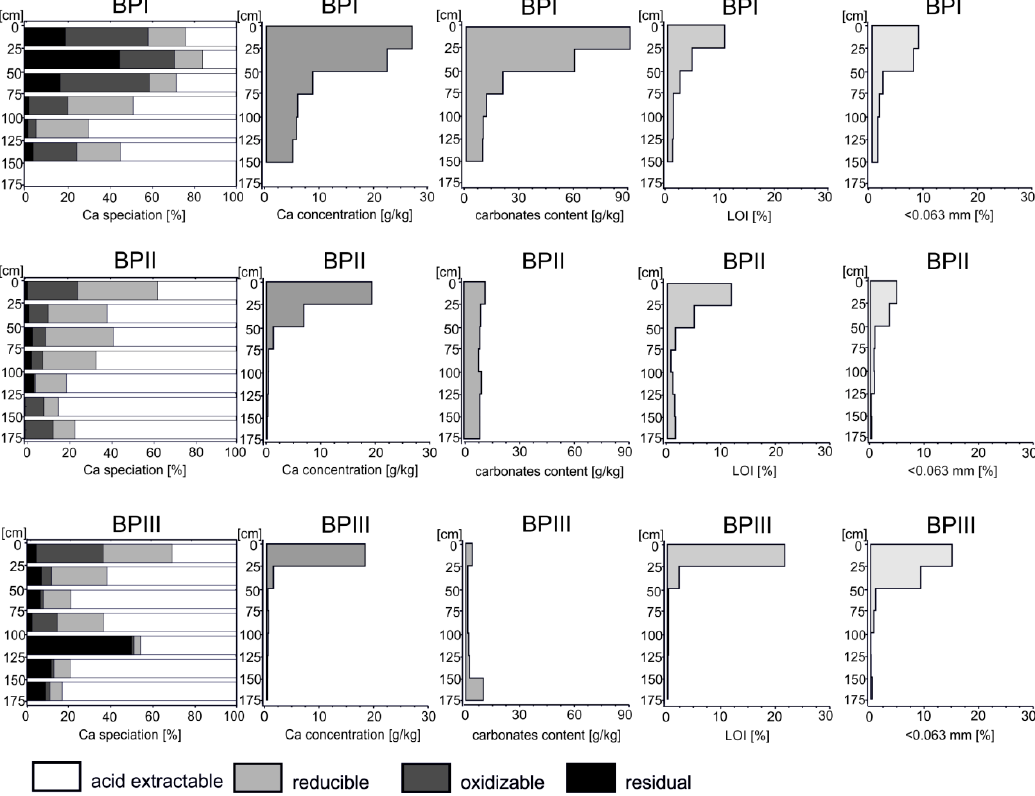
Figure 6. Carbonates, LOI, fine sediment and Ca content and speciation in the Biała Przemsza River sediments.